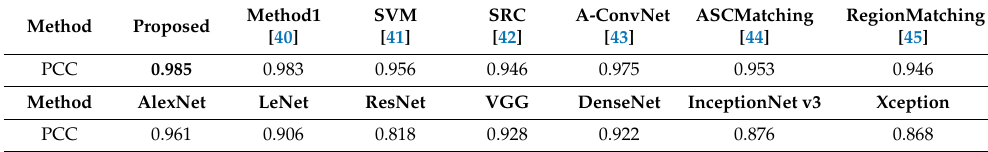
Table 9. Performance of all the methods under SOC.